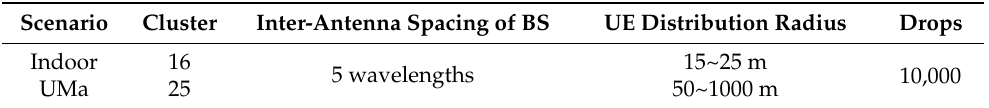
Table 2. List of simulation